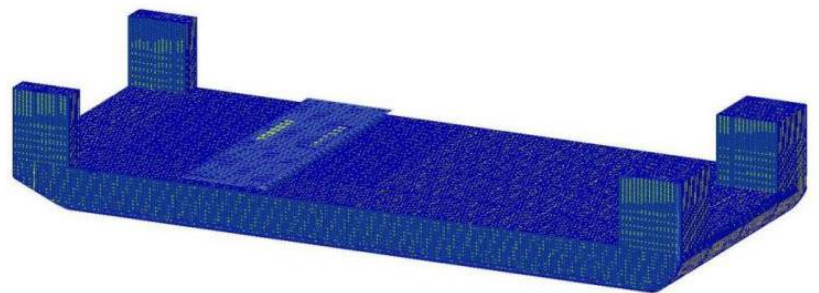
Figure 7. 3D finite element model.